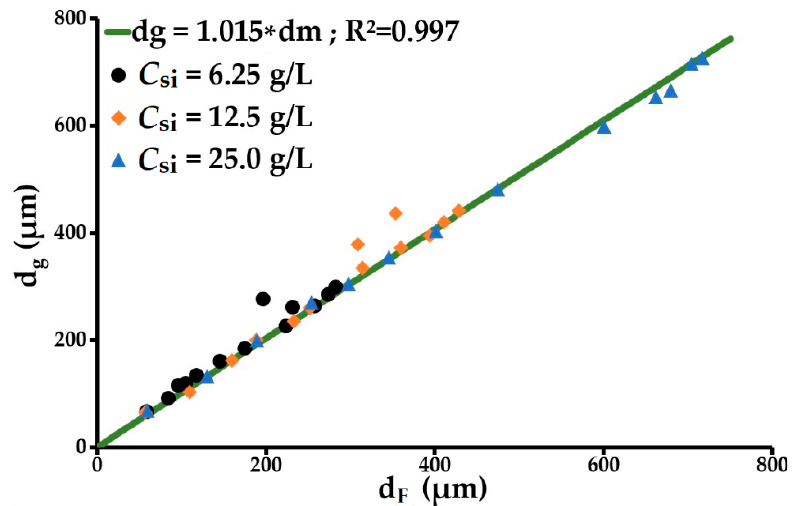
Figure 4. Relationship between the average diameter of flocs and their average gyration diameter. Table 1. Results of applying the proposed model to the analysis of residual turbidity variation with velocity